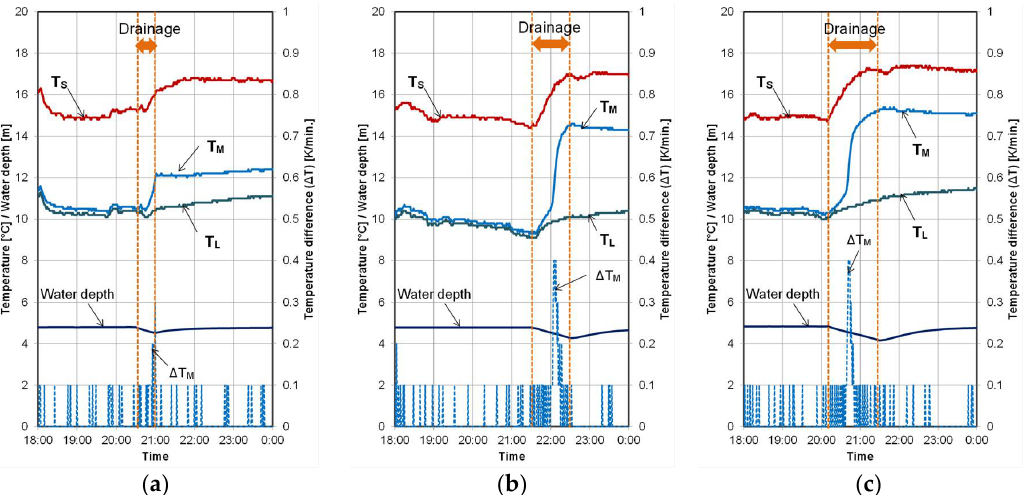
Figure 10. Well-water temperature change and the temperature recovery rate in different drainage durations: ( a ) 0.5 h, ( b ) 1 h, and ( c ) 1.5 h.